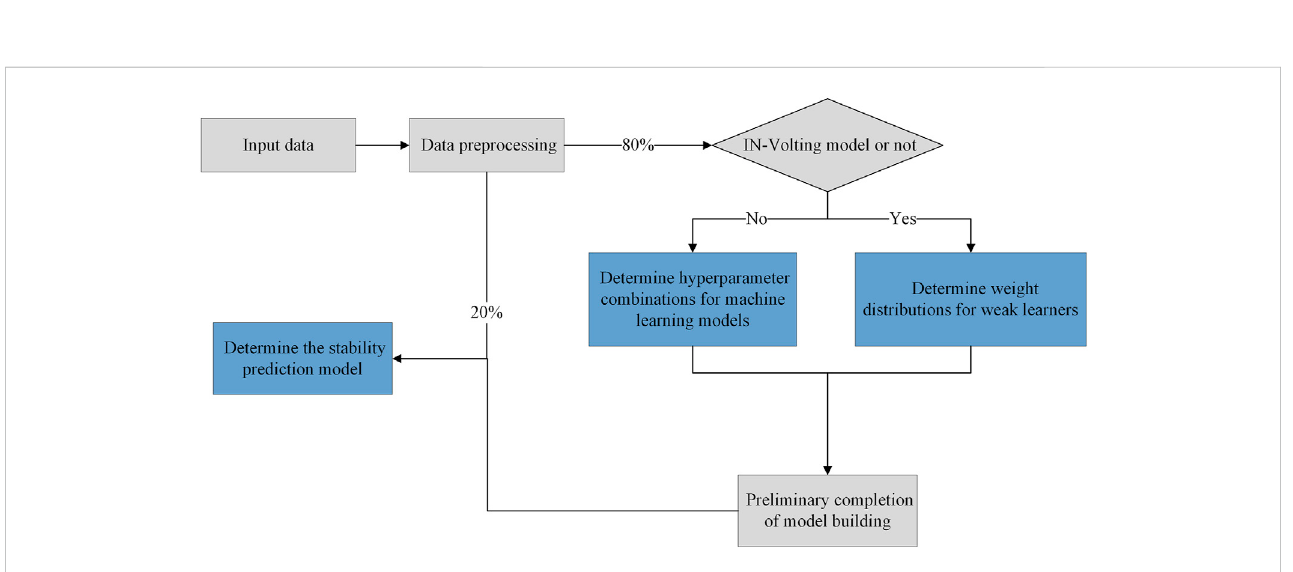
FIGURE 3 Stability prediction model for soil-rock mixture